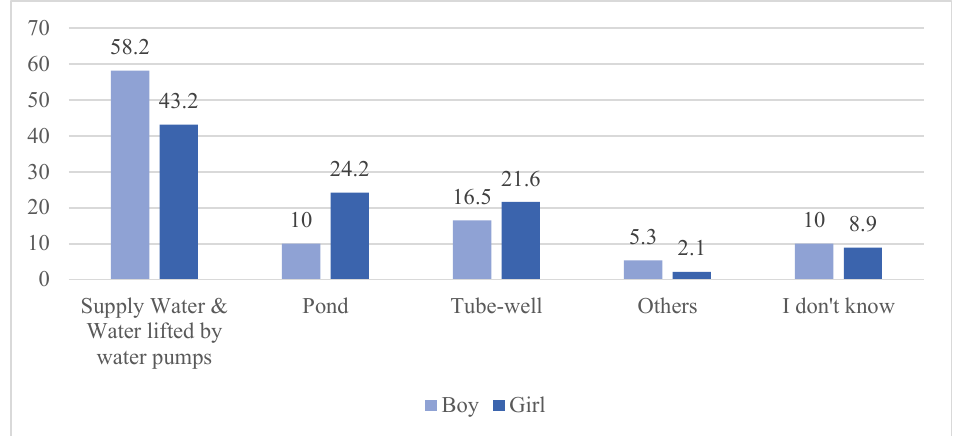
F IGURE 4. P ERCENTAGE DISTRIBUTION OF THE KNOWLEDGE LEVEL OF RESPONDENTS ABOUT SOURCE OF WATER SYSTEMS FOR FIRE EXTINGUISHING AT HOME / EDUCATIONAL INSTITUTIONS